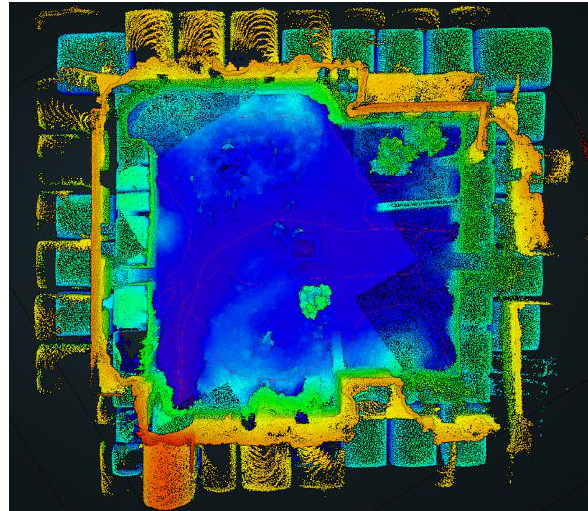
Figure 4. Data from ZEB-REVO